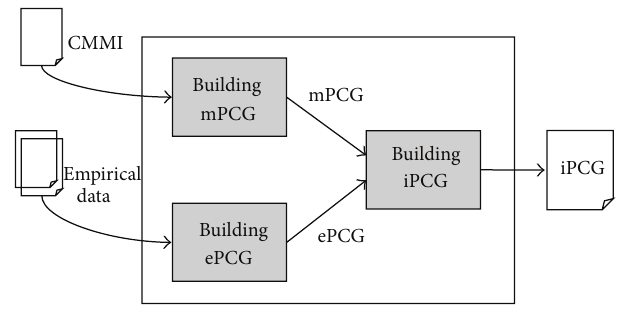
Figure 1: Process correlation